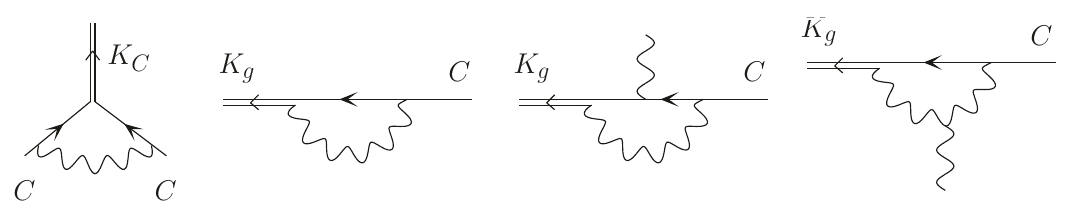
Figure 1 . Diagrams that renormalize the symmetry transformations of the